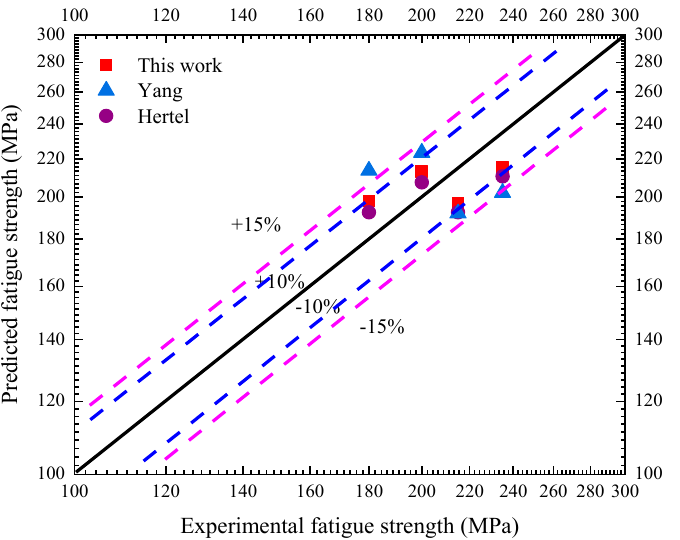
Figure 11. Fatigue strength of notched Q345qD specimens based on different critical distance point point method. method.